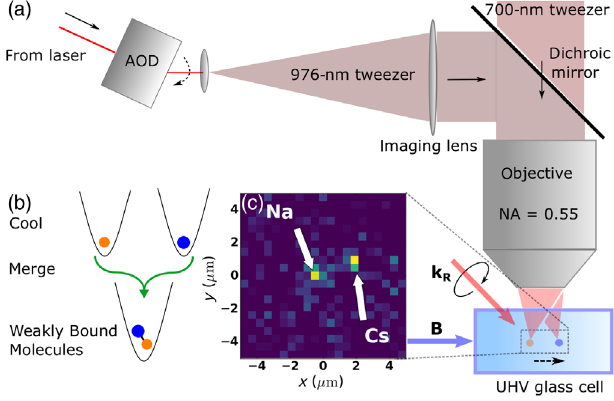
.FIG. 1. Single-atom trapping and transport for molecular assembly. (a) Schematic of apparatus. Two neighboring optical tweezers at 976 and 700 nm trap a single Cs (blue) and Na (orange) atom in the vacuum chamber. Both tweezer beams are combined on a dichroic mirror and focused by an objective. The 976-nm tweezer can be moved in the focal plane by changing the drive frequency of an upstream acousto-optic deflector (AOD). Once atoms are cooled and merged into the same tweezer, a laser propagating along k R transfers them into a bound molecular state in the presence of a quantization B field. (b) Experimental assembly steps of ultracold molecules demonstrated in this paper. A single Na and Cs atom are cooled, merged into the same trap, and transferred to a weakly bound molecule. (c) Single-shot fluorescence image of single Na and Cs atoms in adjacent tweezers separated by 3 μ